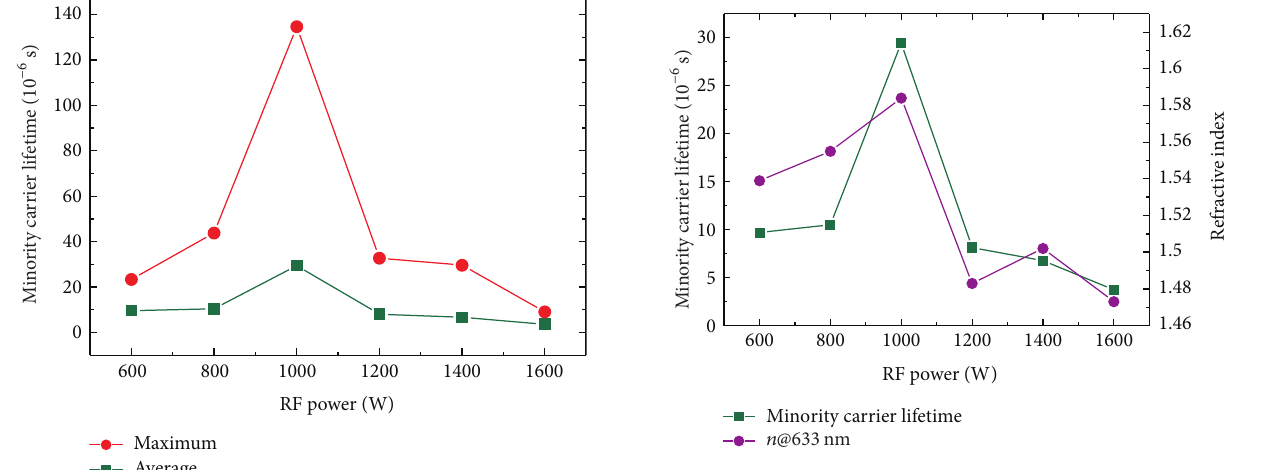
F3: erelationshipbetween theminoritycarrier lifetimeand the sputtering power to the refractive index of the aluminum